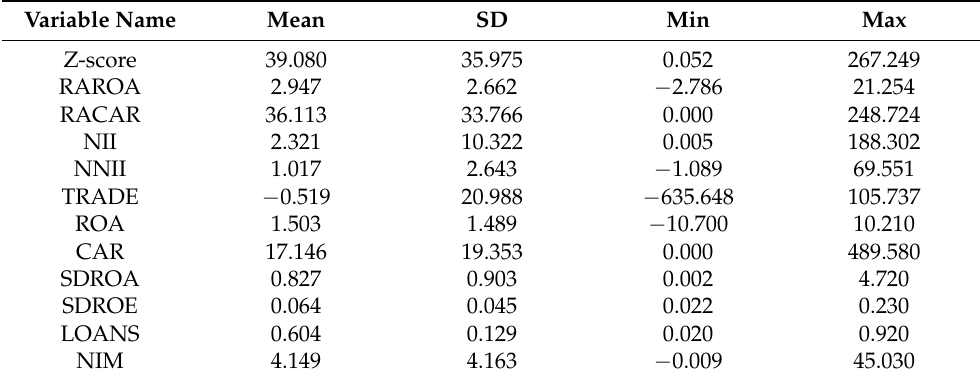
Table 2. Descriptive statistics for all